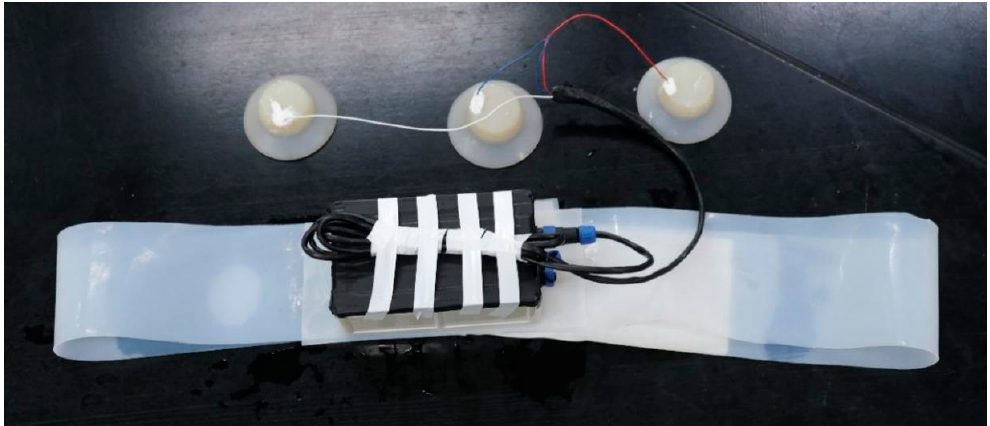
Figure 1. Fully assembled device.